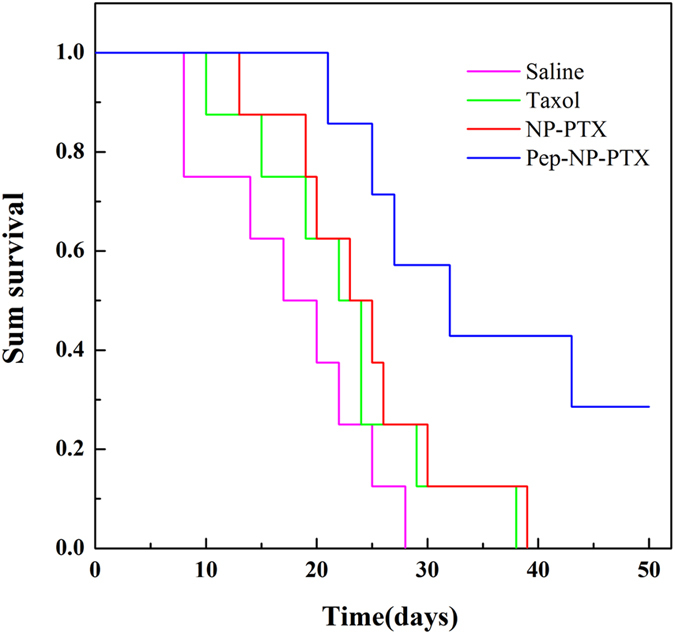
Kaplan-Meier survival curves of C6 glioma-bearing mice treated with different PTX formulations at a dose of 10 mg/kg PTX on day 2, 4, 6 and 8 post implantation.